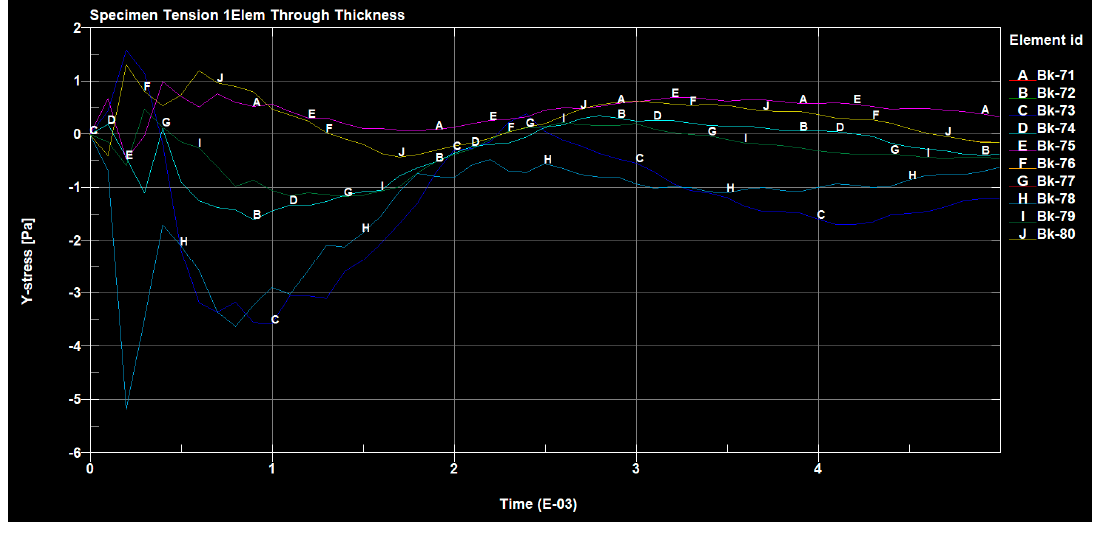
Figure 28. Sample deformation in the 𝑦 direction.